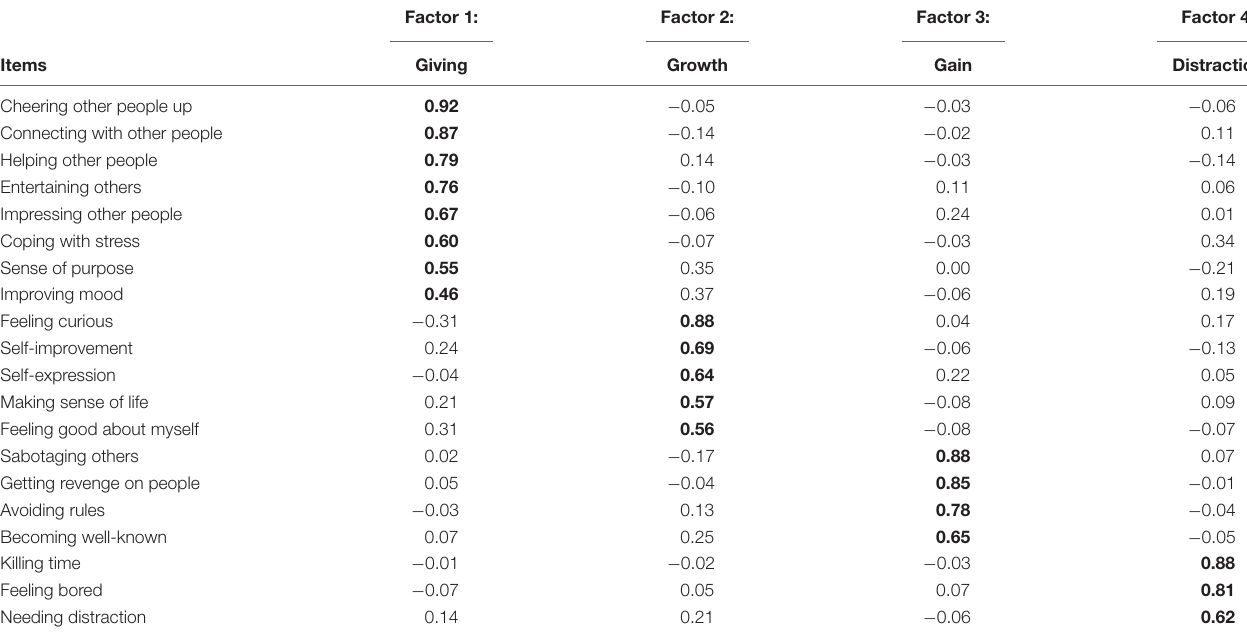
TABLE 2.1 | EFA results for the pooled sample of motivations for creative engagement during lockdown based on a split sample. Factor 1: Factor 2: Factor 3: Factor